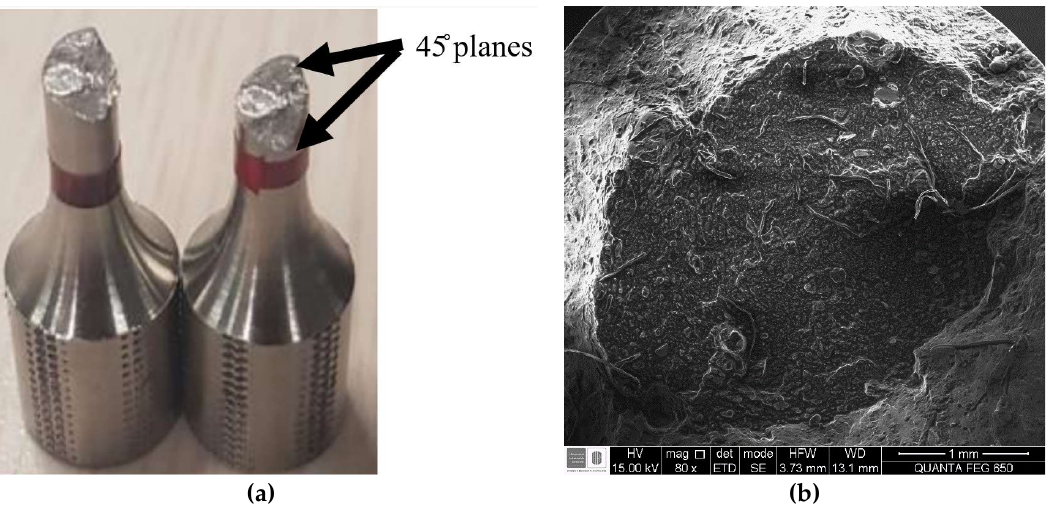
Figure 11. Tensile test: ( a ) macroscopic aspect of the fracture surface; ( b ) shear lips planes.